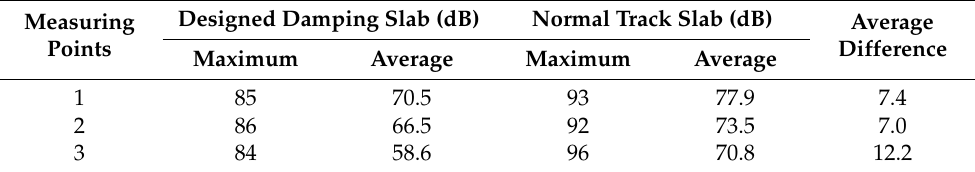
Table 4. The acceleration level for testing points.